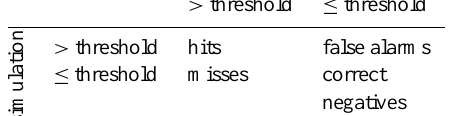
Table 1. Contingency table.